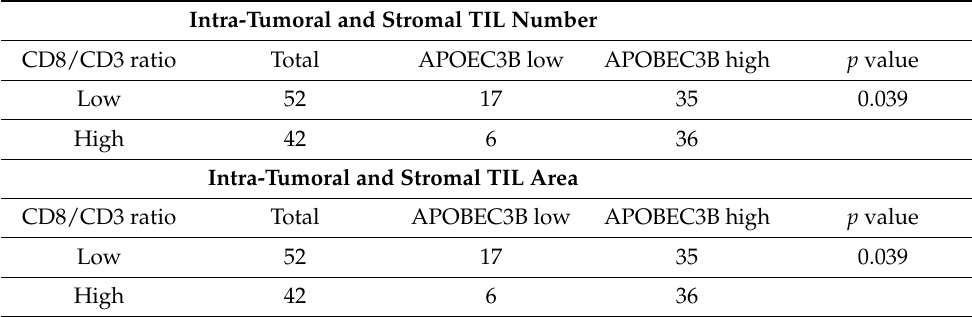
Table 3. Association between APOBEC3B expression and CD8+/CD3+ ratio.